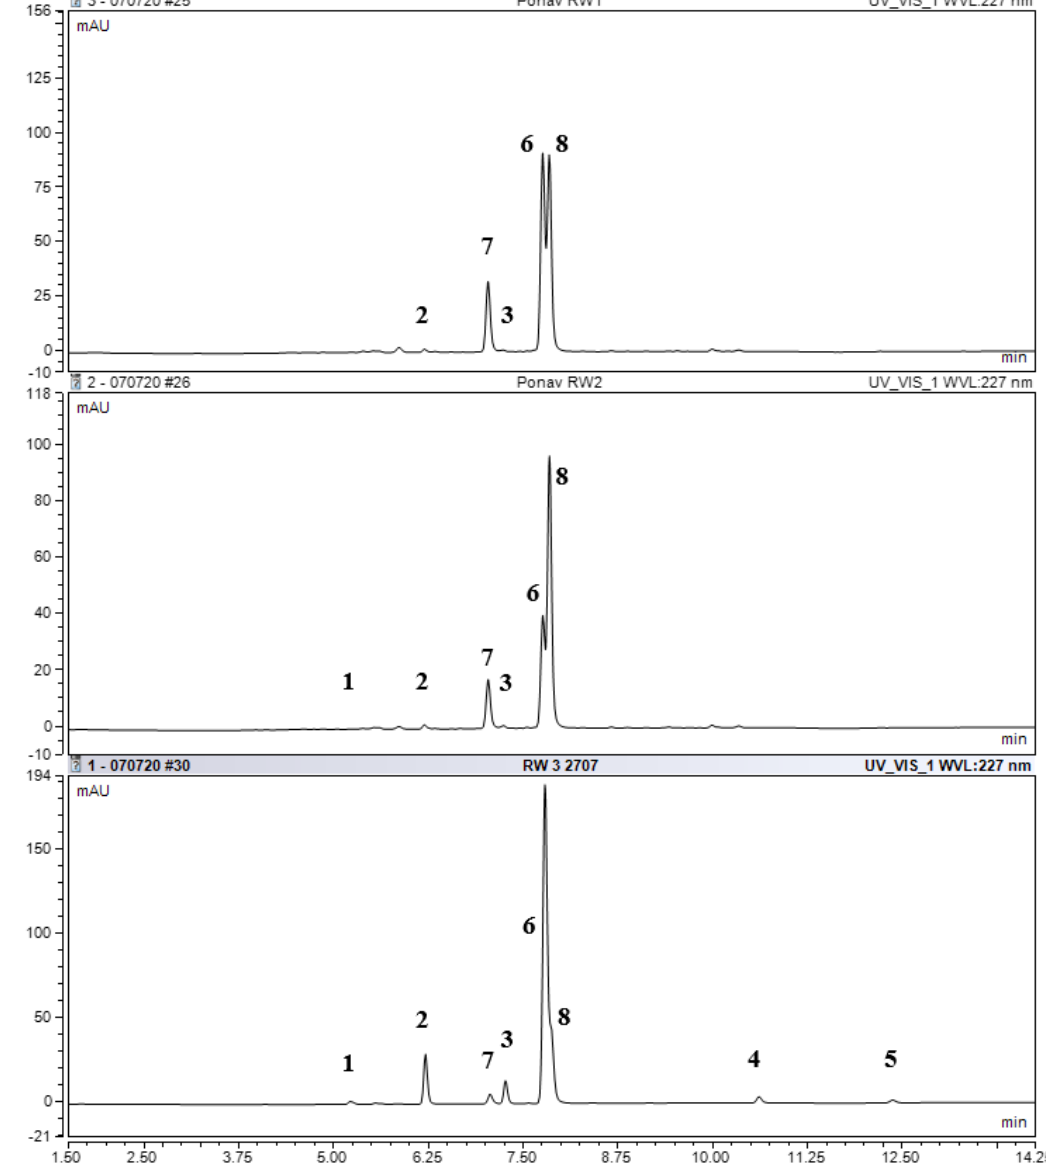
Figure 2. Chromatograms of desulfoglucosinolates (dGSLs): RW1 —extract of 10-days bioreactors N. officinale herb. For compound numbers, refer to Table 2.